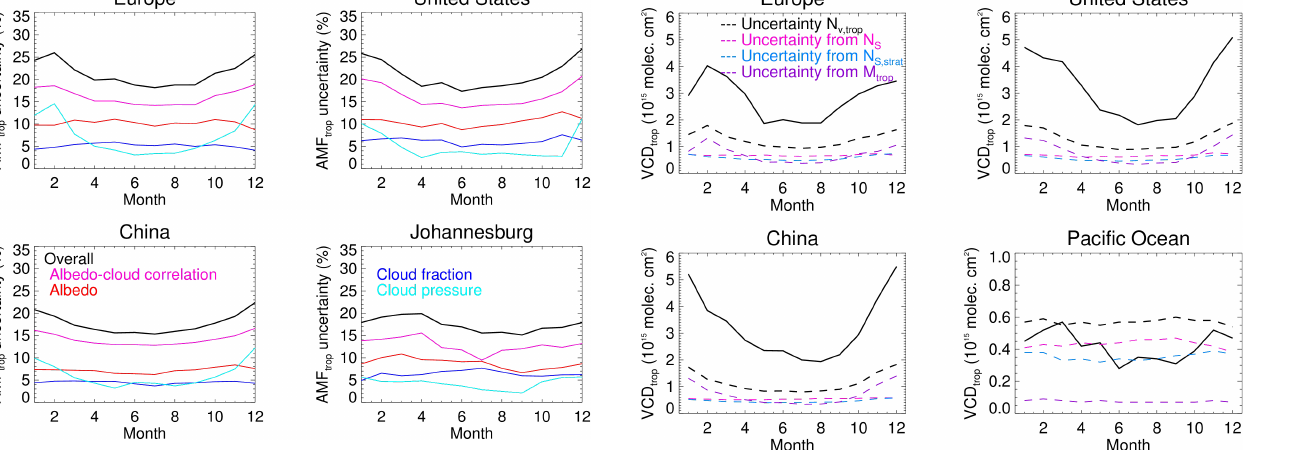
Figure 9. Average (single-pixel equivalent) QA4ECV OMI tropo- spheric NO 2 columns (solid line) and associated total uncertainties (dashed black line) for Europe (40–50 ◦ N, 10 ◦ W–15 ◦ E), United States (35–45 ◦ N, 100–75 ◦ W), eastern China (30–45 ◦ N, 110– 140 ◦ E), and the Pacific Ocean (35–45 ◦ N, 160–140 ◦ W) in 2005. The dashed coloured lines indicate the contributions to the tropo- (cid:16) σ N (cid:17) S ) , strato- spheric NO 2 column uncertainty from SCD (pink, M tr (cid:17) (cid:16) σ N s , strat ) , and the tropospheric spheric correction (light blue, M tr (cid:18) (cid:19) ( N S − N S , strat ) σ M tr ) AMF (purple, M 2 tr